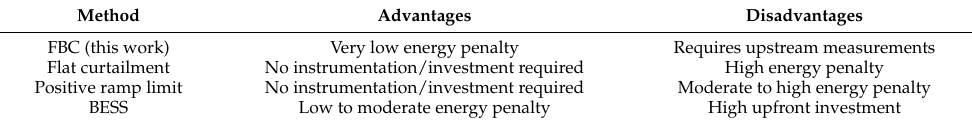
Table 3. Comparison of the FBC method vs. other strategies for short-term ramp